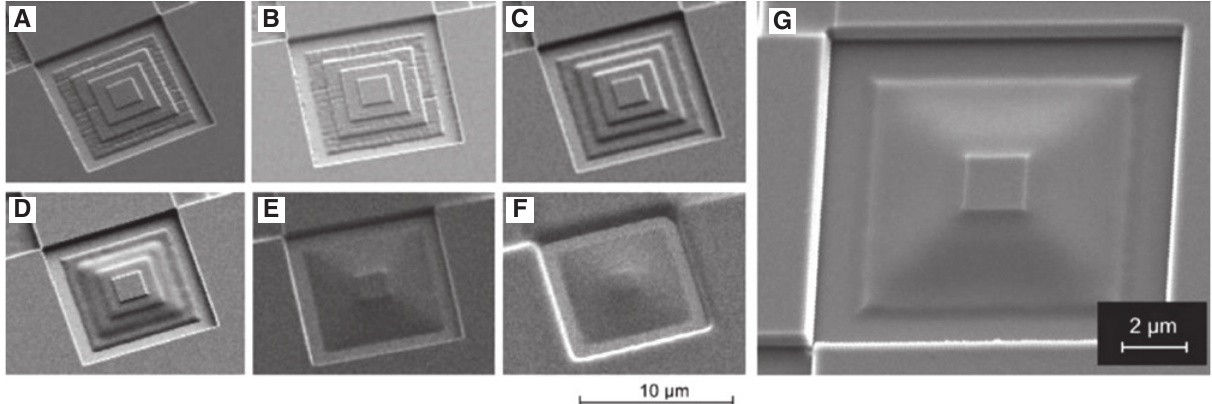
Figure 2: A stepped pyramid obtained via grayscale EBL exposure of PMMA, which has the glass transition temperature of ~ 120 ° C. The shape of the pyramid structure after heating up to different temperatures: (A) 25 ° C, (B) 100 ° C, (C) 110 ° C, (D) 115 ° C, (E) 120 ° C, and (F) 140 ° C; (G) a resist profile transferred into silicon using reactive ion etching [62]. Reprinted with permission from Ref. [62]. Copyright 2010 Institute of